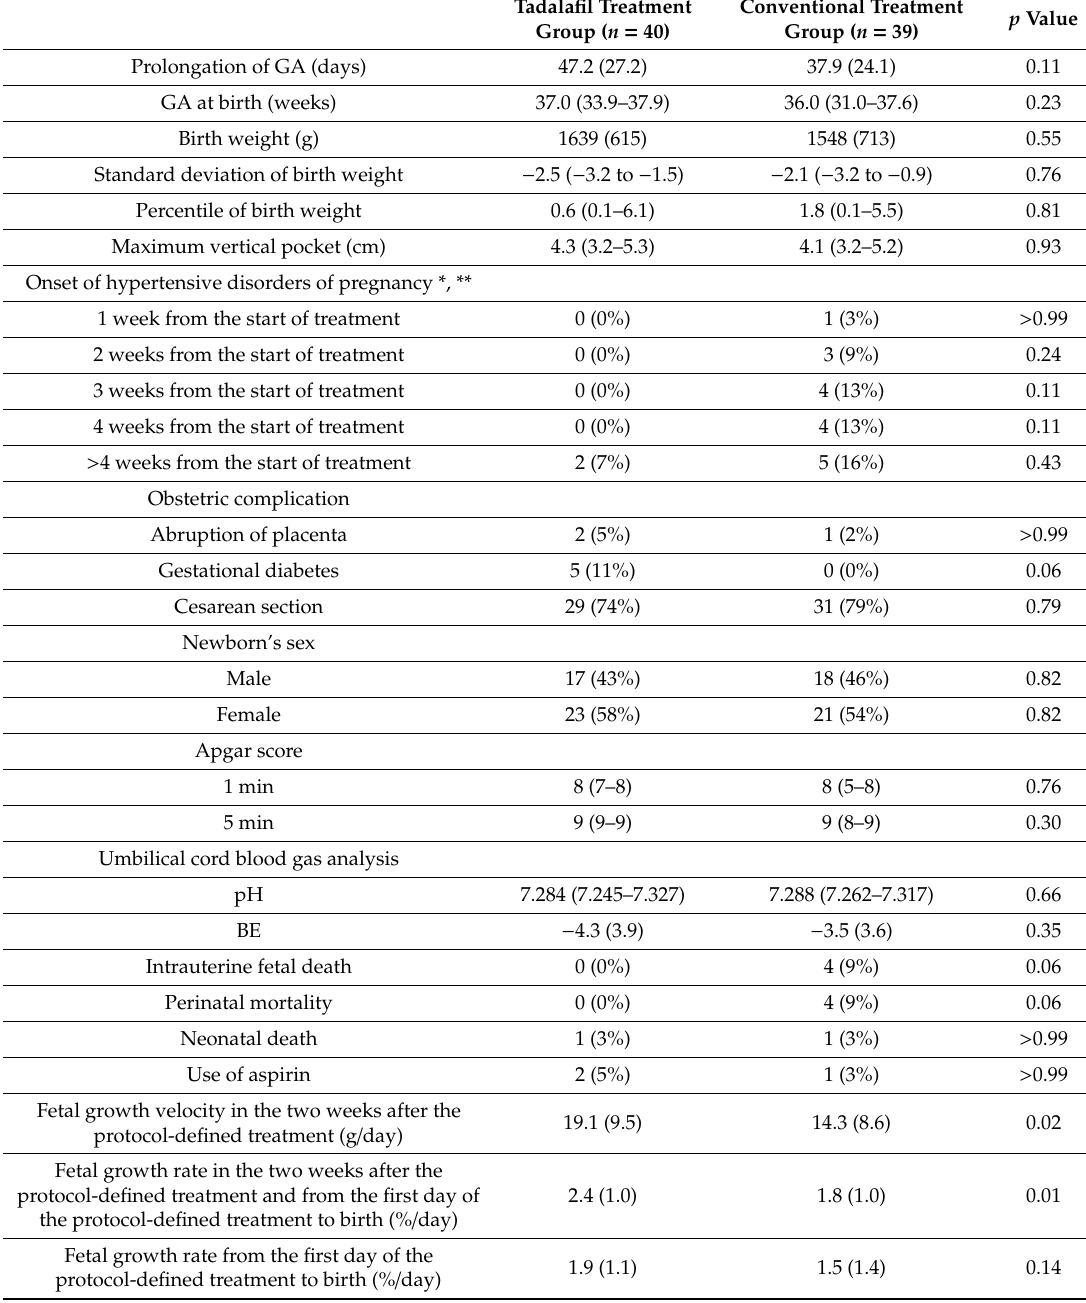
Table 8. Outcome according to treatment as secondary